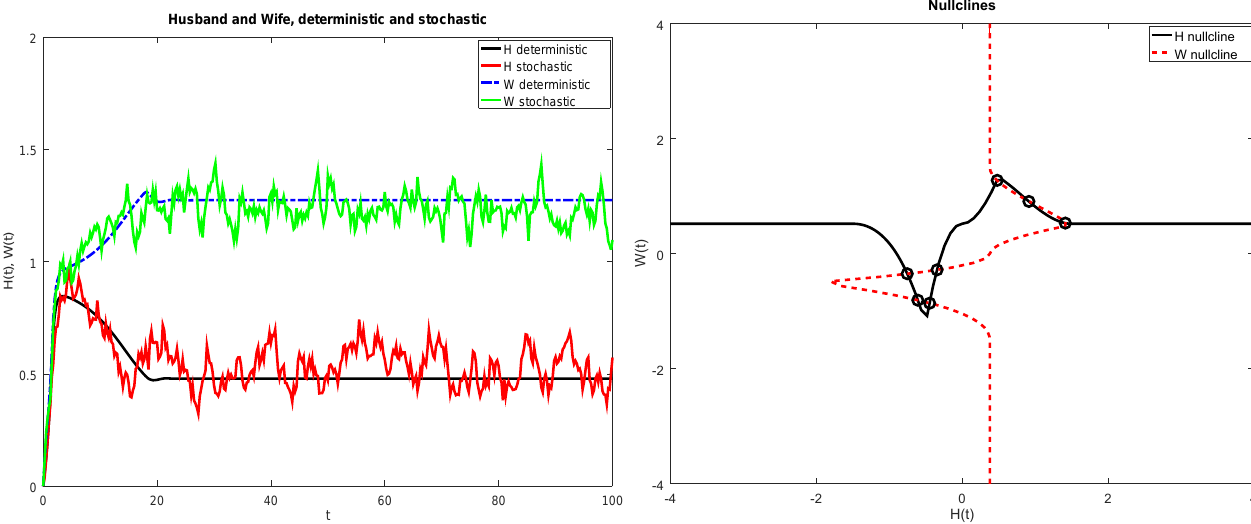
Figure 9. Piece-wise cubic influence functions. Plot of H and W vs. time for the deterministic case and a stochastic realization with initial values H 0 = 0, W 0 = 0 ( left ) and a plot of the nullclines and the equilibrium points ( right